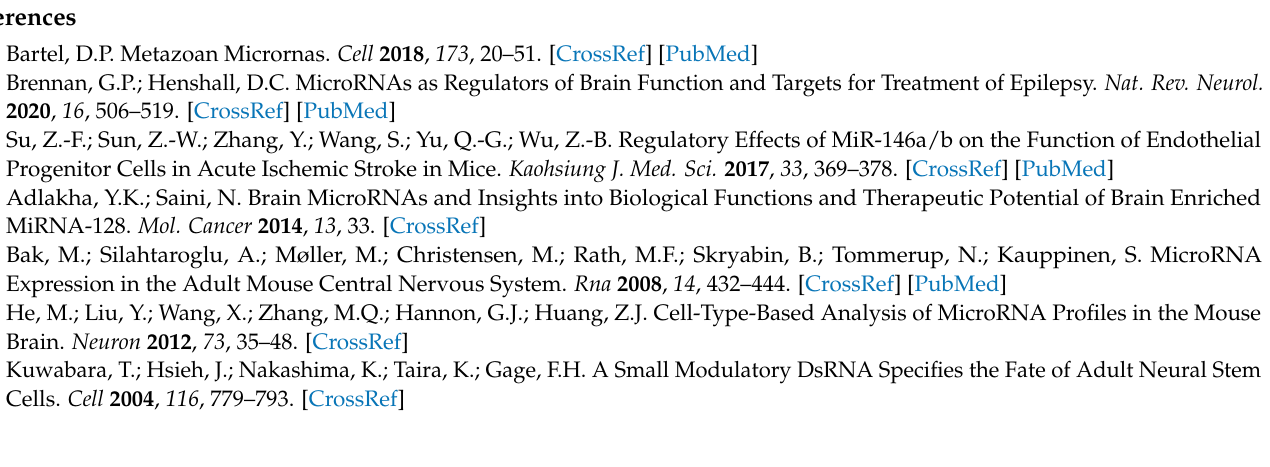
Figure S4: Mir146b -/- mice have no depression-like behavior and social dominant behavior; Figure S5: Representative dot plots of isotype controls used in flow cytometric analysis for gating; Table S1: RT-qPCR Primers used in this study; Table S2: Gene ontology groups with neurological function and targeted by